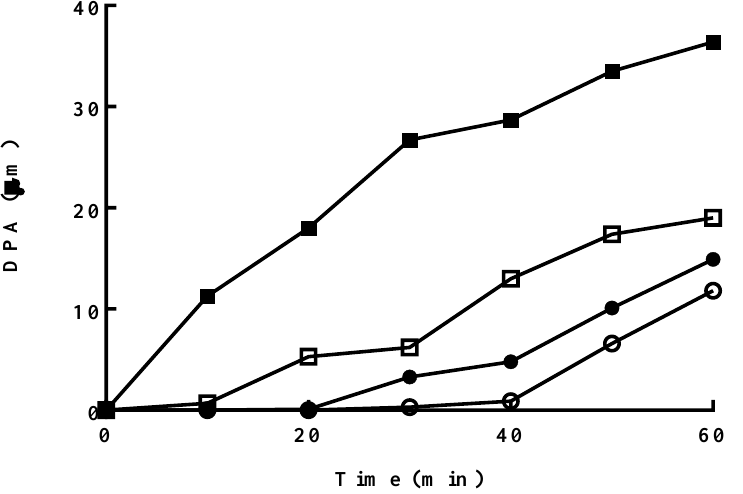
Figure 5. The concentration of DPA ( µ m) released from the spores of C. estertheticum in SDW ( (cid:4) ), C. gasigenes in SDW ( (cid:3) ), C. estertheticum in BSA ( • ), C. gasigenes in BSA ( ) during treatment with sporicidal product 1.